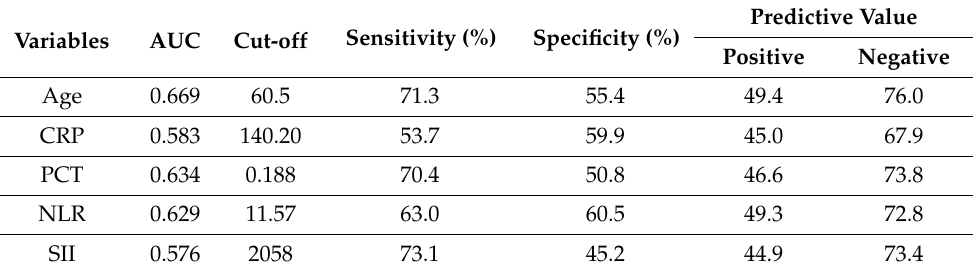
Table 5. The statistical characteristics of the ROC curve for the univariate logistic